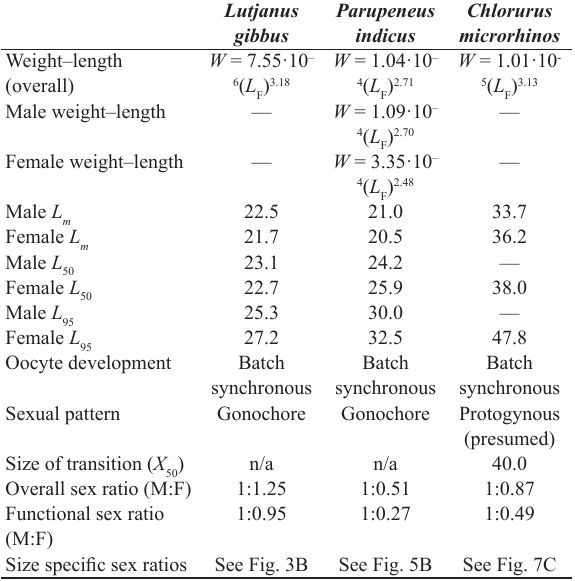
Table 1. Summary of weight–length relations and reproduc - tive information for four exploited reef fishes from Fiji. L the length of the smallest mature individual. L lengths comprising 50% and 95% mature individuals, respec- tively. Lengths are in